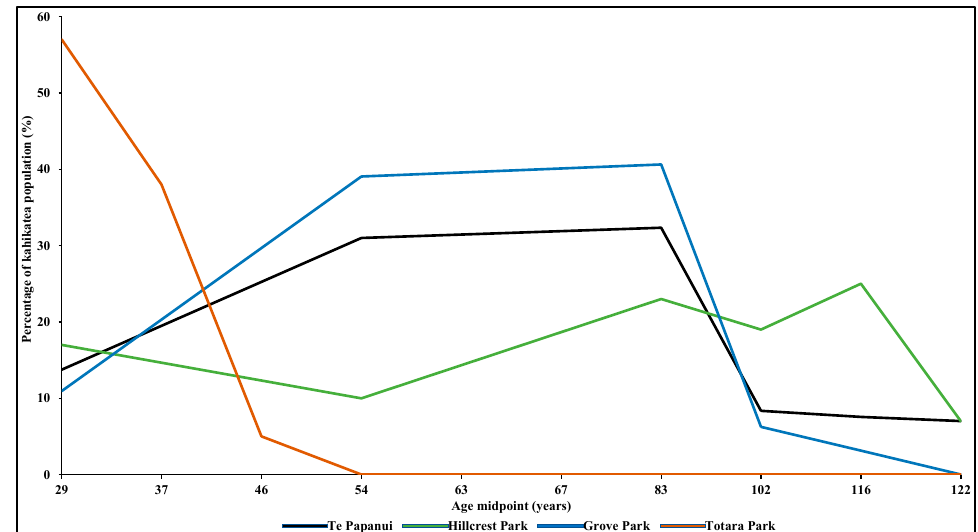
Figure 3. The percentage of kahikatea at each age midpoint for the four remnants. Totara Park is represented by younger age midpoints (29, 37, 46, 54, 63 and 67 years) than Te Papanui, Hillcrest Park and Grove Park (29, 54, 83, 102, 116 and 122 years) due to the use of different DBH-age regression equations. Ages were predicted from the J.R. Leathwick (unpublished) regression equation for Te Papanui, Hillcrest Park and Grove Park, and from the D.A. McLean (unpublished) regression equation for Totara Park.